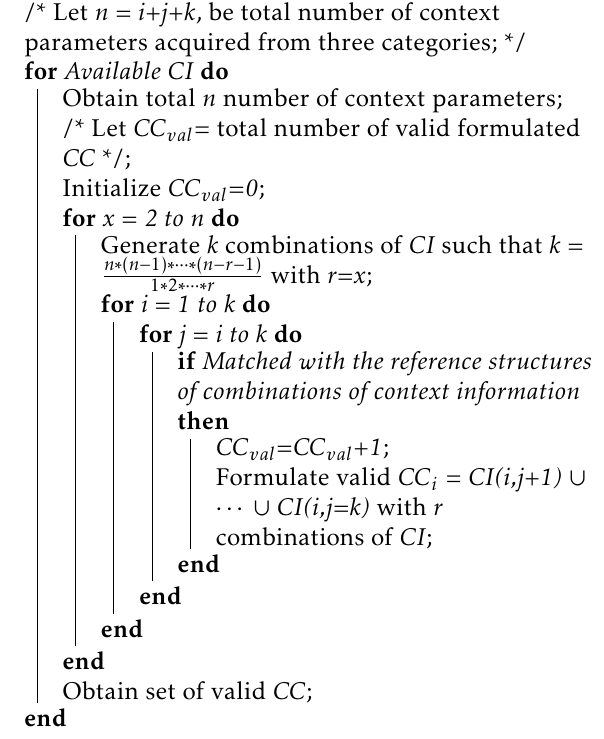
Algorithm 1: Formation of Composite